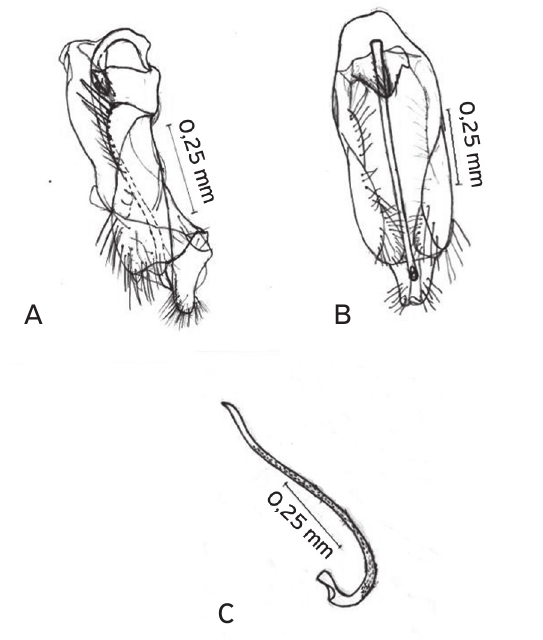
Figura7. (A) Terminália genital masculina de Neosilba perezi em vista lateral (176X). (B) Terminália genital masculina de Neosilba perezi em vista ventral (176X). (C) Edeago de Neosilba perezi em vista lateral